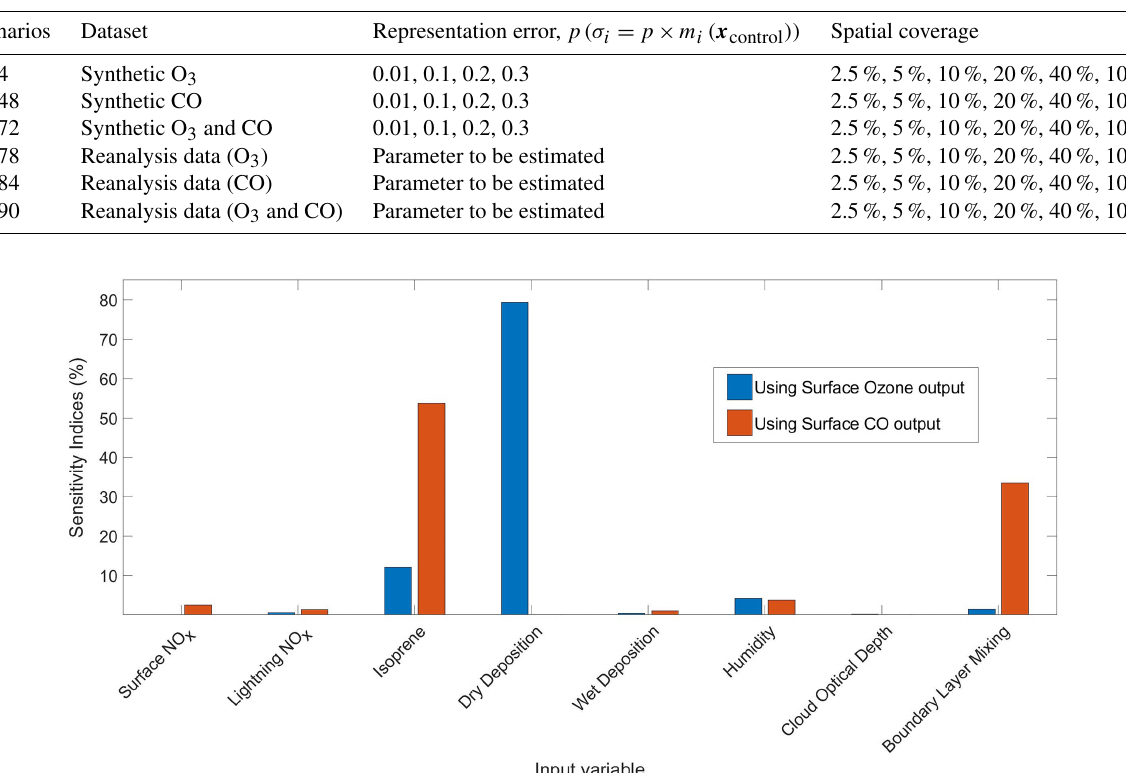
Table 2. Summary of the 90 different MCMC scenarios carried out for this study. The scenarios involved varying (i) the type of data (synthetic or reanalysis); (ii) the representation error used for the synthetic data ( p) , where m i ( x control ) is the control run output of the CTM, and σ i is the amount of statistical noise added; (iii) the percentage coverage of grid squares in the USA and Europe. For the synthetic data, the 24 scenarios correspond to a full factorial combination of four levels of representation error and six levels of spatial coverage, while for the reanalysis data the six scenarios correspond to the six levels of spatial coverage.